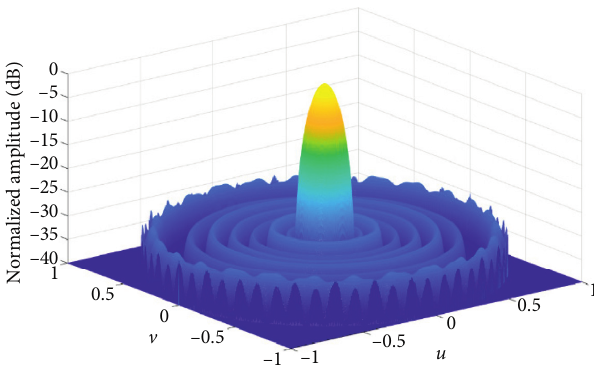
Figure 1: 3D pattern of the UECRA when N �